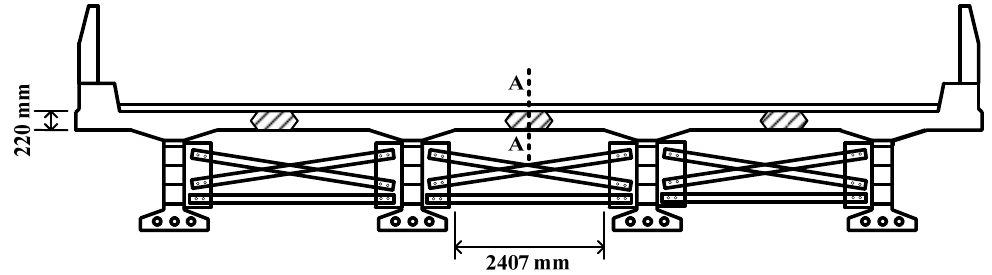
Figure 2. Schematic of the precast modular girder bridge.